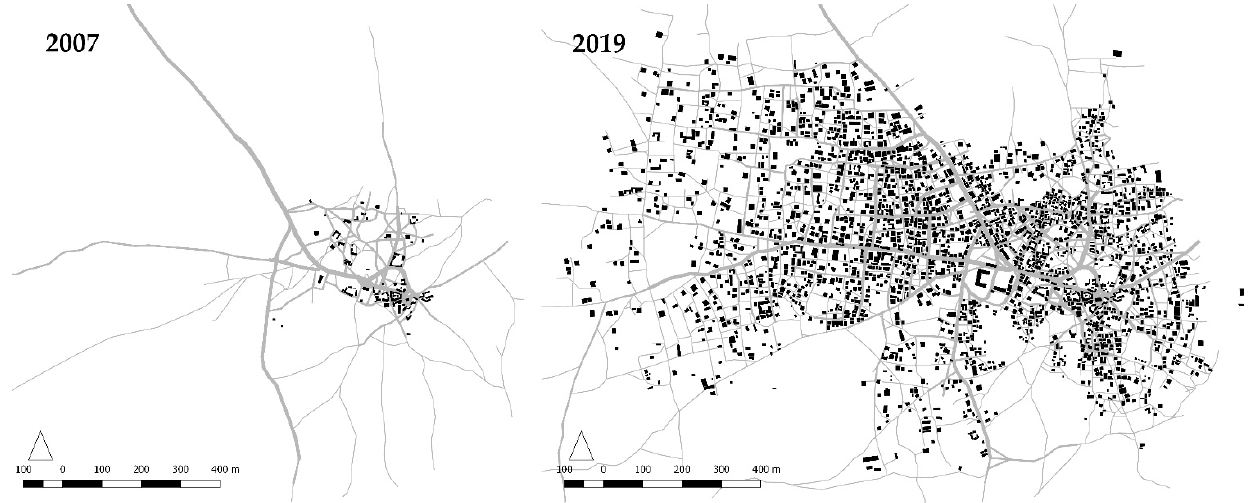
Figure 1. Selected case study 2007–2019.